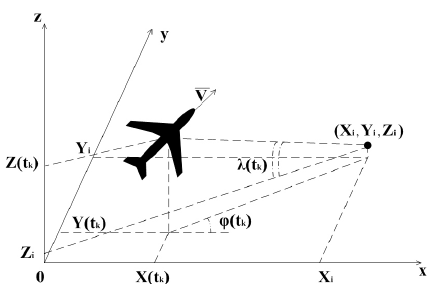
Figure 3. Scheme of the measurements of bearing angles. X i , Y i , Z i are the coordinates of the i -th feature point; λ ( t k ) , φ ( t k ) are the elevation and azimuth bearing angles, measured at the moment t k .